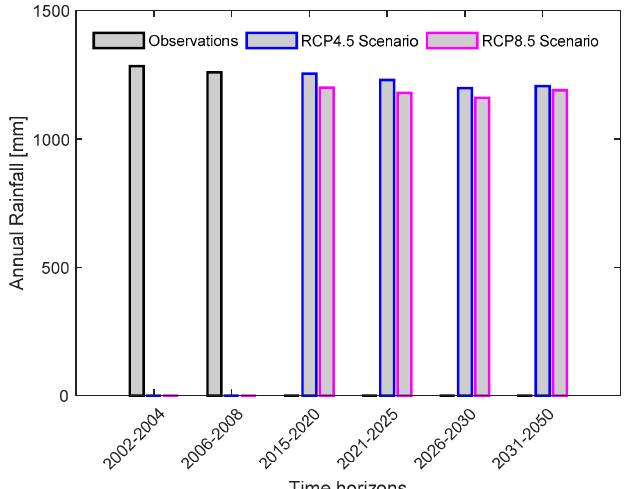
Figure 2. Observed precipitations and regional climate model (REMO) corrected precipitations scenarios.